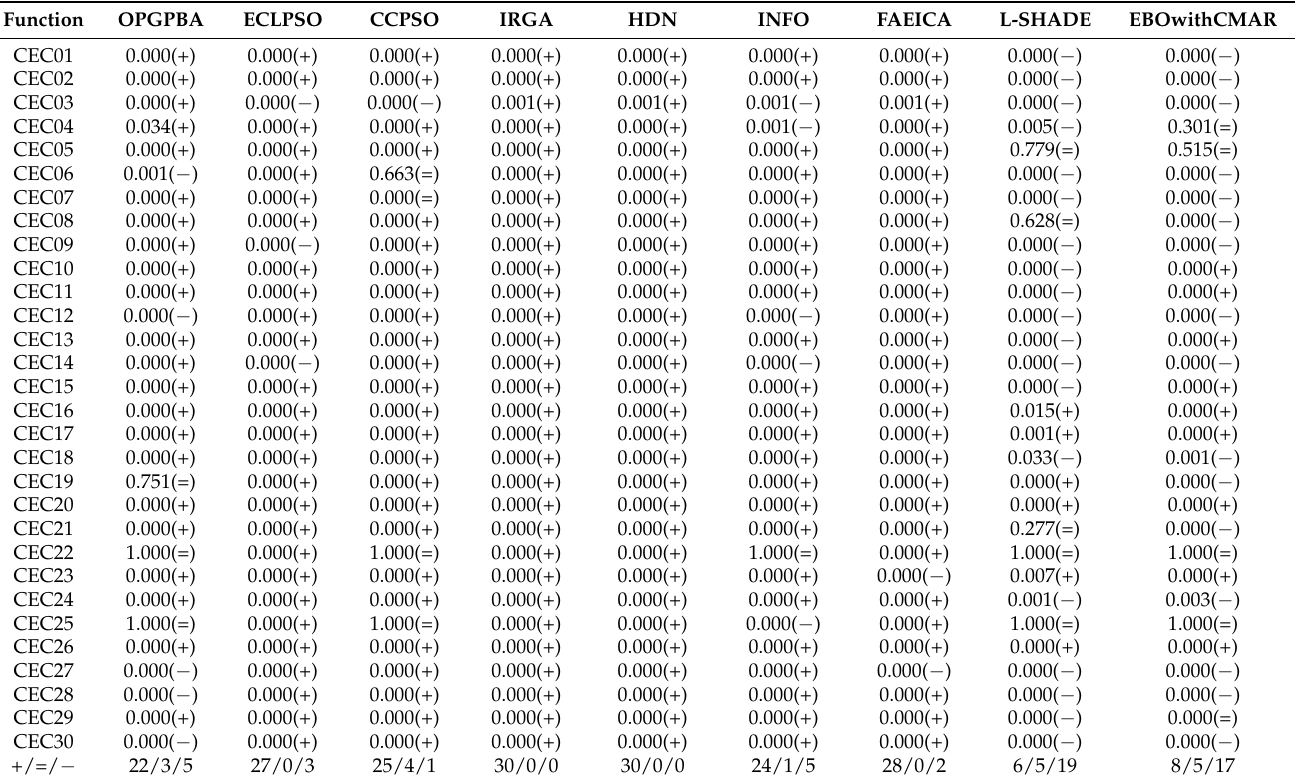
Table 12. Wilcoxon signed rank test results ( p -values) of 30-D CEC2017 problem analysis.